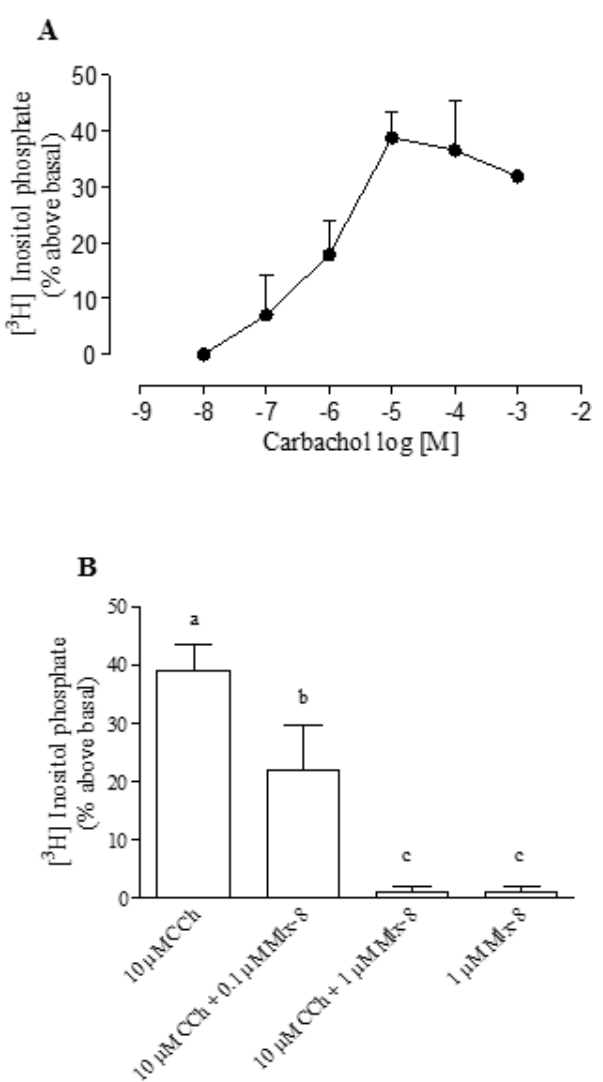
Figure 5. ( A ) Concentration-effect curve of carbachol (CCh) on total [ 3 H] inositol phosphate accumulation. ( B ) Effect of the Mlx-8 toxin on total [ 3 H] inositol phosphate accumulation induced by 10 –5 M CCh in the hippocampi from male rats. Each point and vertical line represent the mean ± S.E.M. of n = 3. Different letters indicate statistical significance (p < 0.05; ANOVA, Newman-Keuls